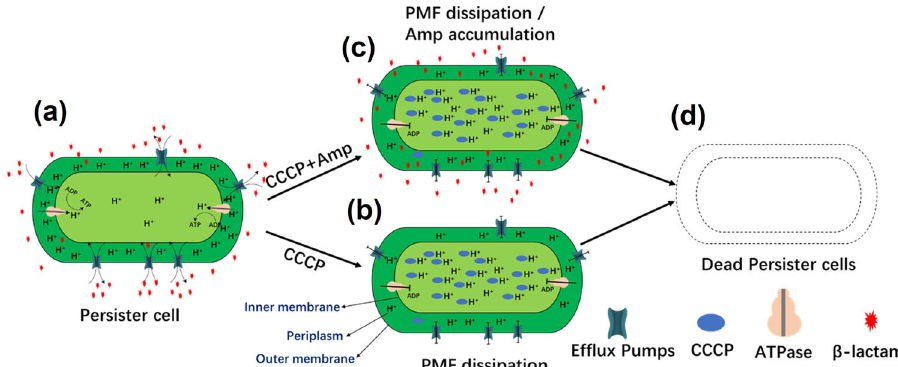
Fig. 6 Proposed model of PMF-mediated development of starvation-induced tolerance. a Maintaining PMF is essential for the prolonged survival of starvation-induced tolerant cells. Although bacteria may not be able to support a strong PMF when entering the tolerance phase, they nevertheless maintain a basic PMF level upon encountering starvation for a prolonged period. Ef fl ux activities driven by PMF extrude β -lactams to facilitate tolerance formation; other membrane protein activities which presumably involve the import/export of speci fi c metabolites/nutrients are supported by PMF and are also important for maintaining a tolerance phenotype. b Effect of PMF dissipators such as CCCP on tolerant cell killing. PMF dissipators cause rapid dissipation of bacterial membrane PMF and hence inhibition of ATP production, which in turn affects a series of cellular functions that are involved in maintaining the tolerance phenotype, leading to the killing of the tolerant cells. c Effect of PMF dissipator and ampicillin on tolerant cell killing. Tolerant cells are eradicated more effectively in the presence of β -lactam if PMF cannot be maintained under starvation stress. Dissipation of bacterial membrane PMF suppresses antibiotic ef fl ux activities, leading to accumulation of antibiotics in the periplasm of tolerant cells. The accumulation of antibiotics and arrest of other cellular functions lead to the more effective killing of tolerant cells. d Complete dissipation of PMF with or without the presence of antibiotics results in the death of tolerant